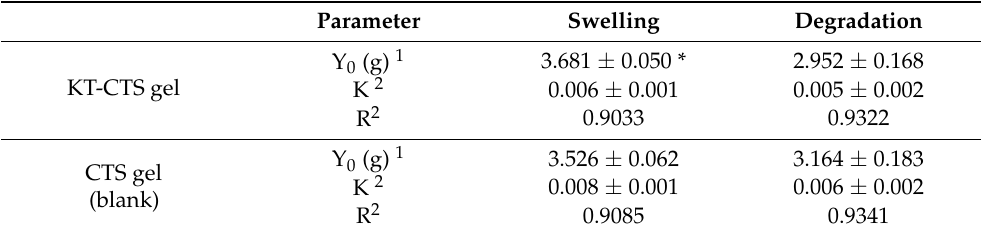
Table 1. Best-fit values of the swelling and degradation processes of CTS gel with and without KT.